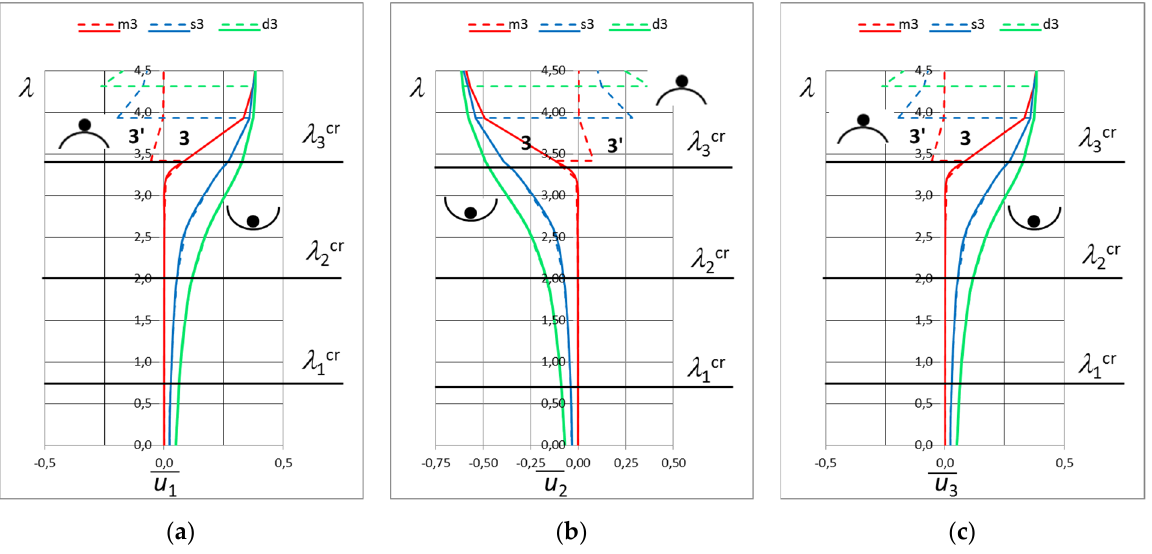
Figure 10. Equilibrium path obtained for small, medium and large amplitudes of the geometric imperfections in the shape of third buckling mode, respectively ( m 3, s 3 and d 3); displacement of the node: ( a ) No. 1, ( b ) No. 2, ( c ) No. 3.